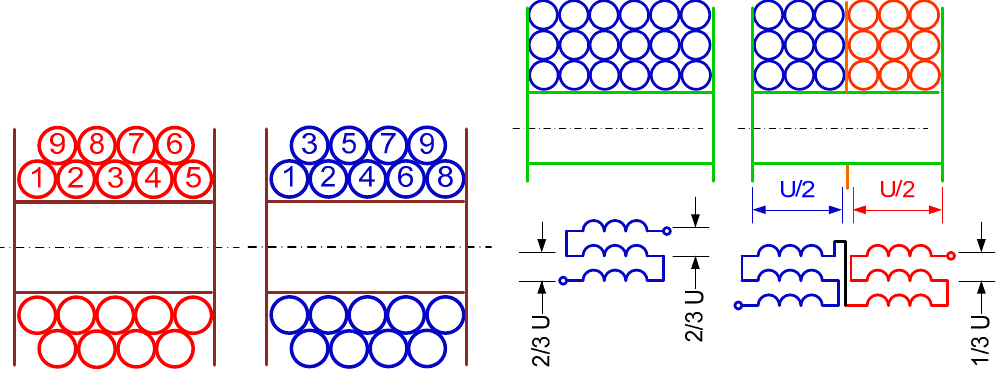
Figure 9. Winding with no transposition (red) and transposed winding (blue) reducing the stray capacitance ( left-side figure); winding divided into sections ( right-side figure).